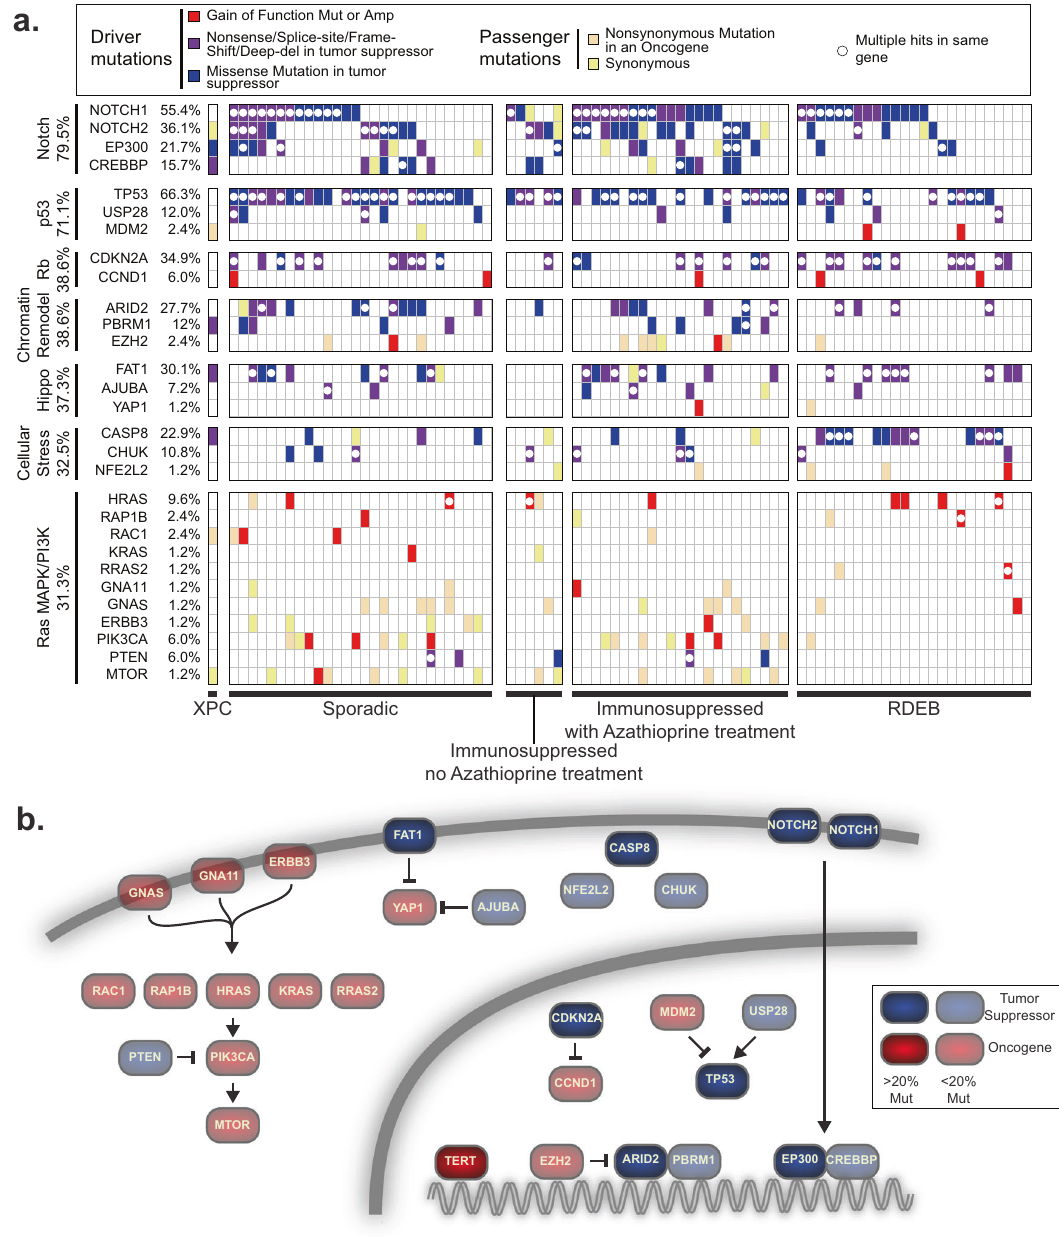
Fig. 4 The landscape of driver mutations in cutaneous squamous cell carcinoma. a Tiling plot of the genetic alterations (rows) in each tumor (columns). Genes and tumors are further organized into pathways and clinical subtypes. The percentages of samples harboring pathogenic alterations are indicated. Mut mutation, Amp ampli fi cation, XPC xeroderma pigmentosum, RDEB recessive dystrophic epidermolysis bullosa. b Pathways affected. TERT was not implicated in this study, which focused on coding mutations, but is included here because it is known to have promoter mutations, as